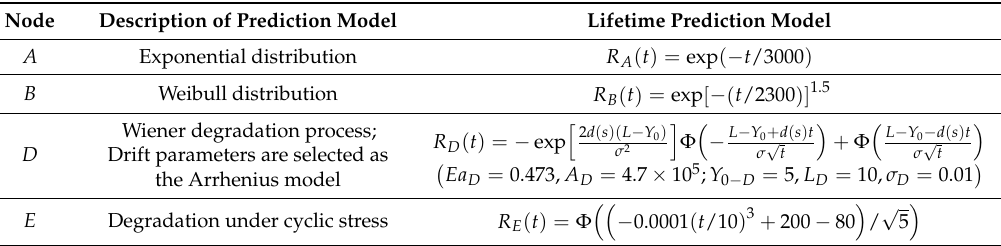
Table 2. Prediction model (1) of four pieces of